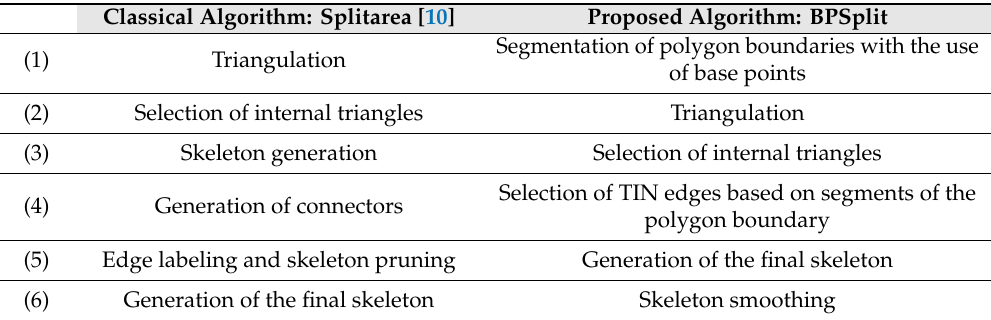
Table 1. Process of generating a skeleton with the Splitarea algorithm and the Base Point Split algorithm.